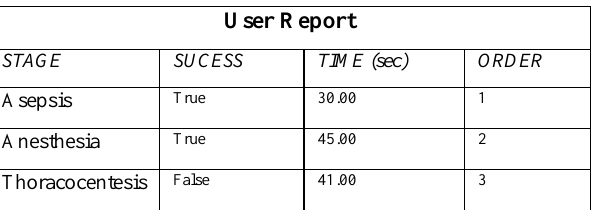
M ODEL OF R EPORT F ILE WITH U SER D ATA .